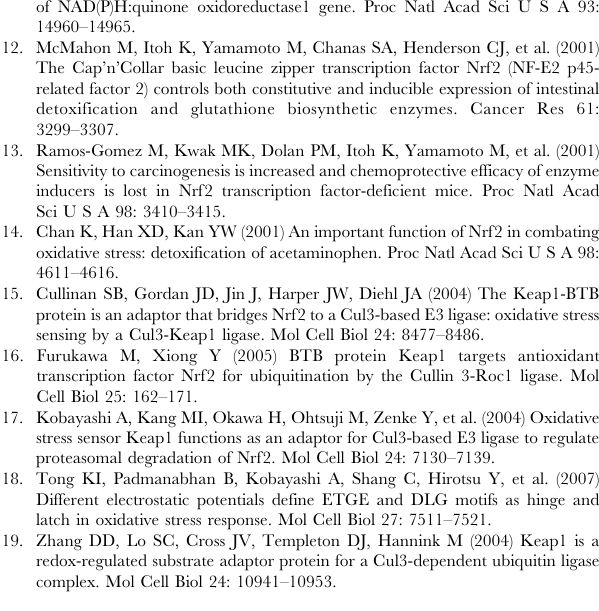
Figure S2 HEK293T cells were co-transfected with expression vectors for NF- k B p65, along upstream kinases IKK a and IKK b in HEK293T cells. Phosphorylation of p65 at S536 by IKKs was confirmed by an antibody that recognizes this site-specific modification (Cell Signaling, Cat # 3033S). The antibody for phospho-S/TP did not pick up any signal above background, indicating the specificity of this